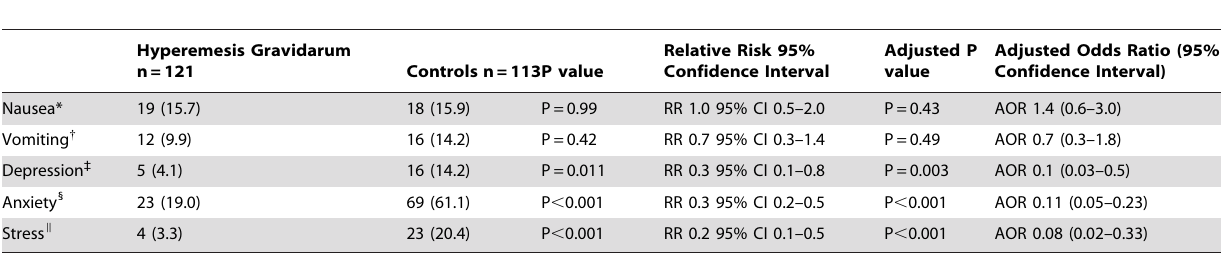
Table 4. Nausea, Vomiting, Depression, Anxiety and Stress in the Third Trimester in Women Previously Hospitalised with Hyperemesis Gravidarum Compared to